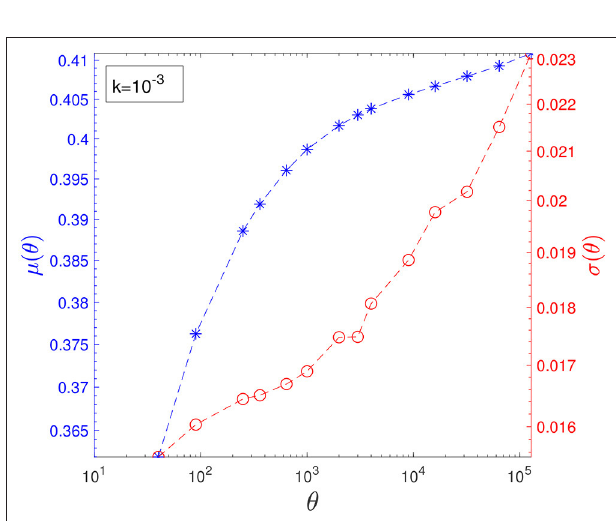
FIGURE 5 | Log-log plot of the mean and standard deviation of P ( ρ ) as a function of θ .